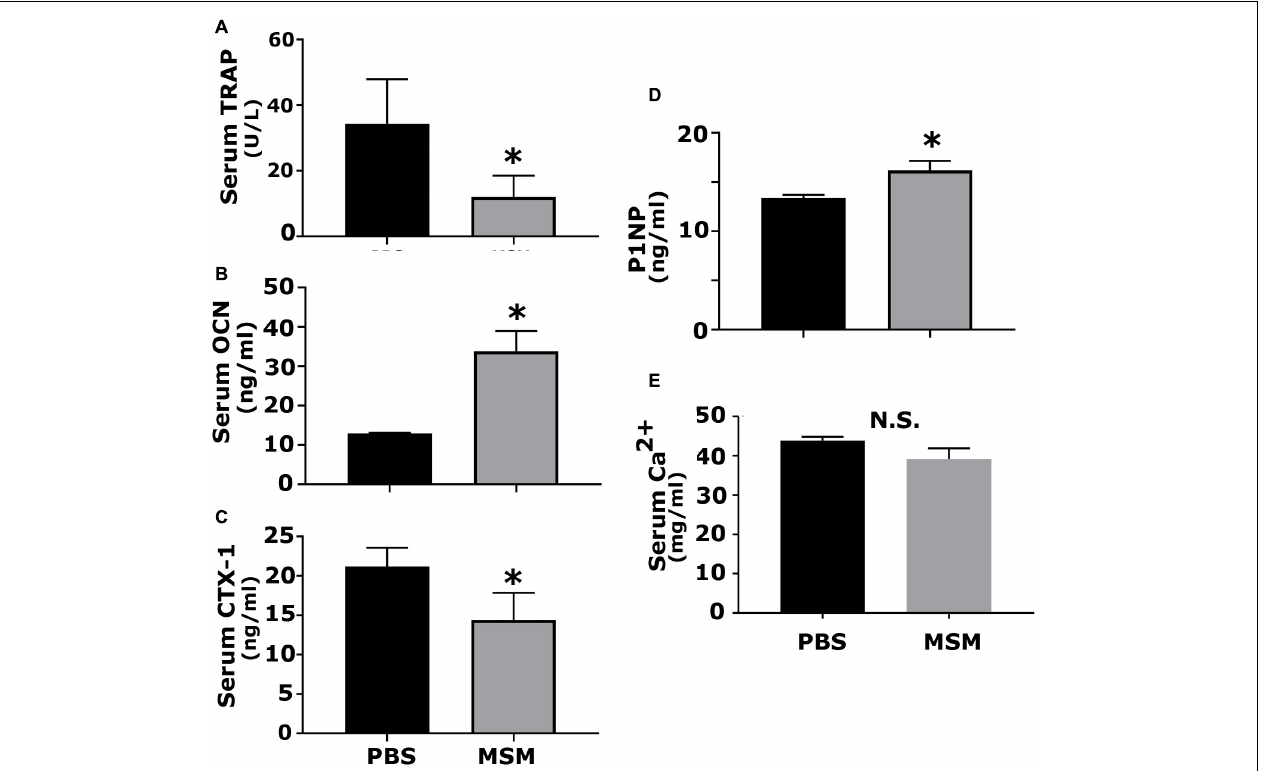
FIGURE 7 | Analysis of the serum levels of indicated biomarkers of bone formation and resorption in mice injected with PBS and MSM. The serum levels of (A) TRAP, (B) OCN, (C) CTX-I, (D) P1NP, and (E) calcium were measured using ELISA kits. Serum from six mice per injection was used for the analyses, and each analysis was performed in triplicates. The results are presented as mean ± SEM; standard Student’s t -test was used to analyze the p -value; ∗ p < 0.05; N.S., not statistically